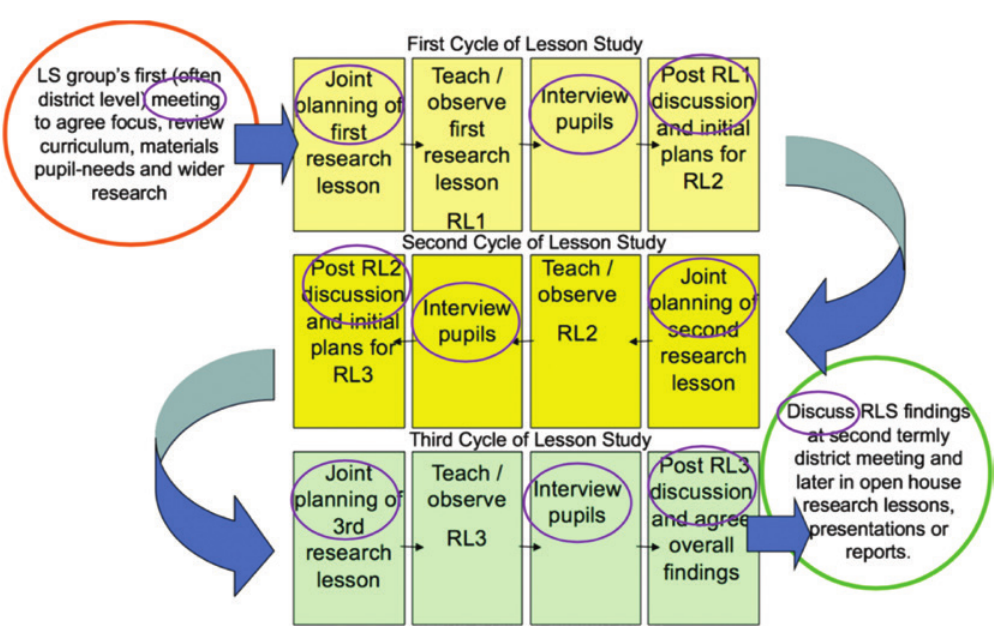
Figure 2: The district-level research lesson study process used in Camden (elements demanding teachers’ use of exploratory talk to solve problems and analyse findings are